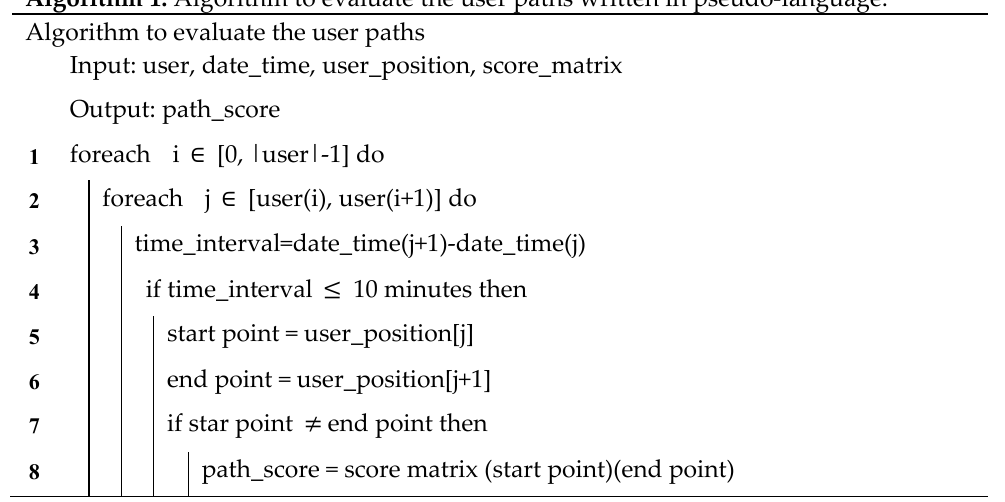
Algorithm 1: Algorithm to evaluate the user paths written in pseudo-language. Algorithm to evaluate the user paths